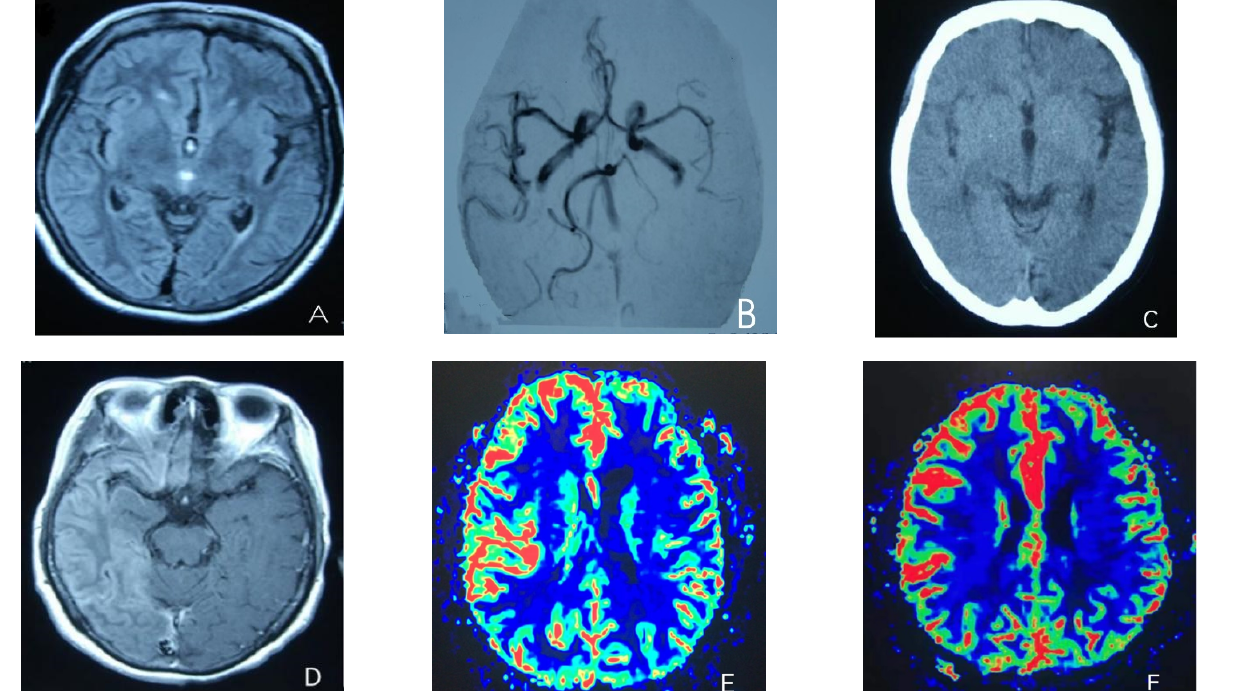
Figure 1. ( A ) Cortical swelling in the right cerebral cortex (the 2nd day); ( B ) the MCA and PCA branches decreased (the 3rd day); ( C ) swelling of right cerebral cortex (the 7th day); ( D ) swelling and diffuse enhancement in the cortex of the right cerebral hemisphere; ( E , F ) right hemisphere hyperfusion.